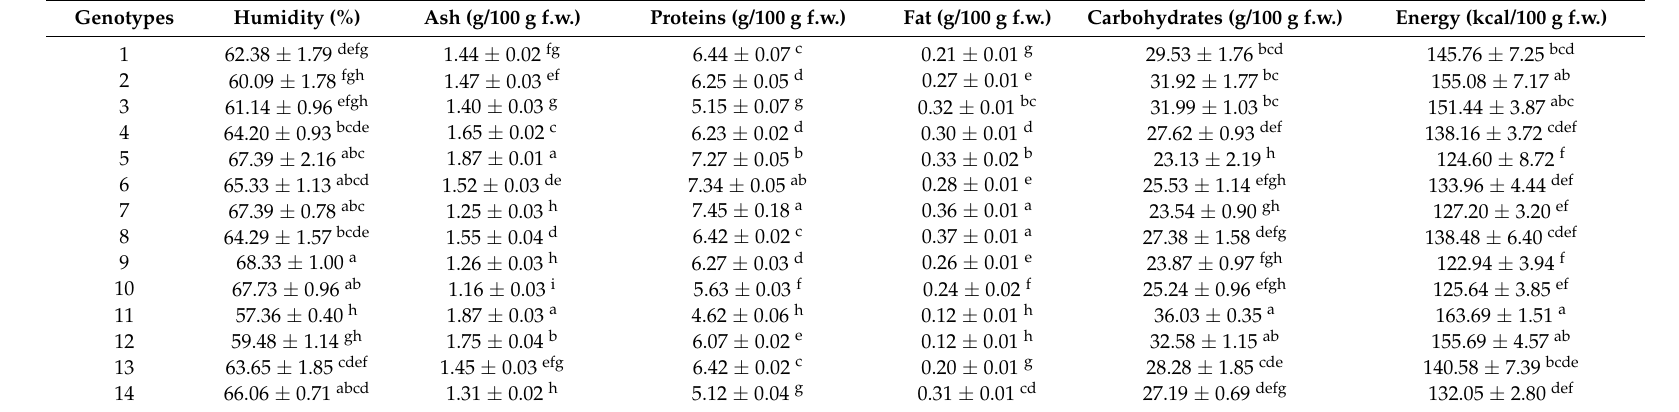
Table 2. Nutritional value of the studied garlic genotypes (mean ± SD; n =